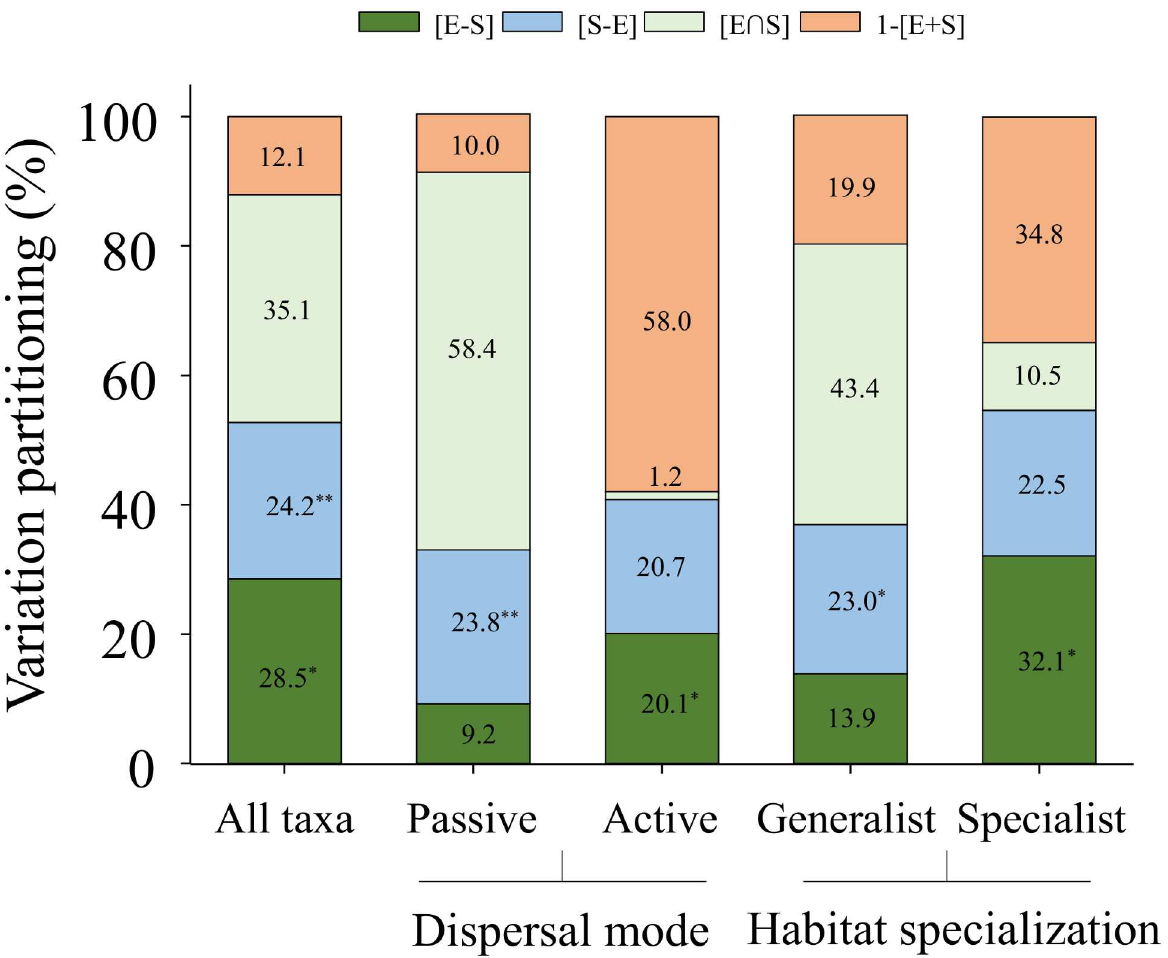
Fig 2. Variation partitioning (%) of the beach invertebrate taxa. Histogram showingall the invertebrate taxa plus four reduceddata- matrices containing passive and active dispersers(dispersalmode) and generalistand specialist(habitat specialization) groups. All the models obtainedusing a forward selectionprocedure(DistLM sequentialtest, 9999 permutations). Components distinguished pure environmental variation[E-S], pure spatialvariation[S-E], the variation componentthat is shared by both [E \ S], and the unexplained variation1-[E+S]. * p < 0.05; ** p <